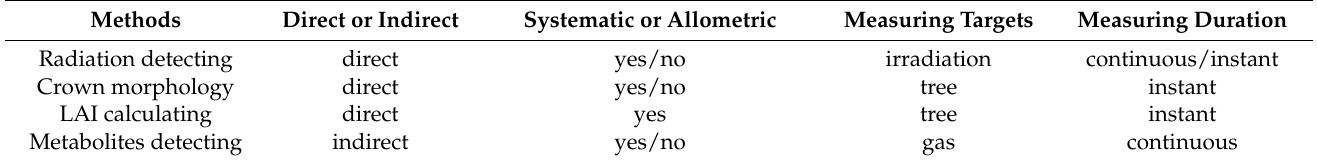
Table 1. Summary of different methods to assess light conditions for a single